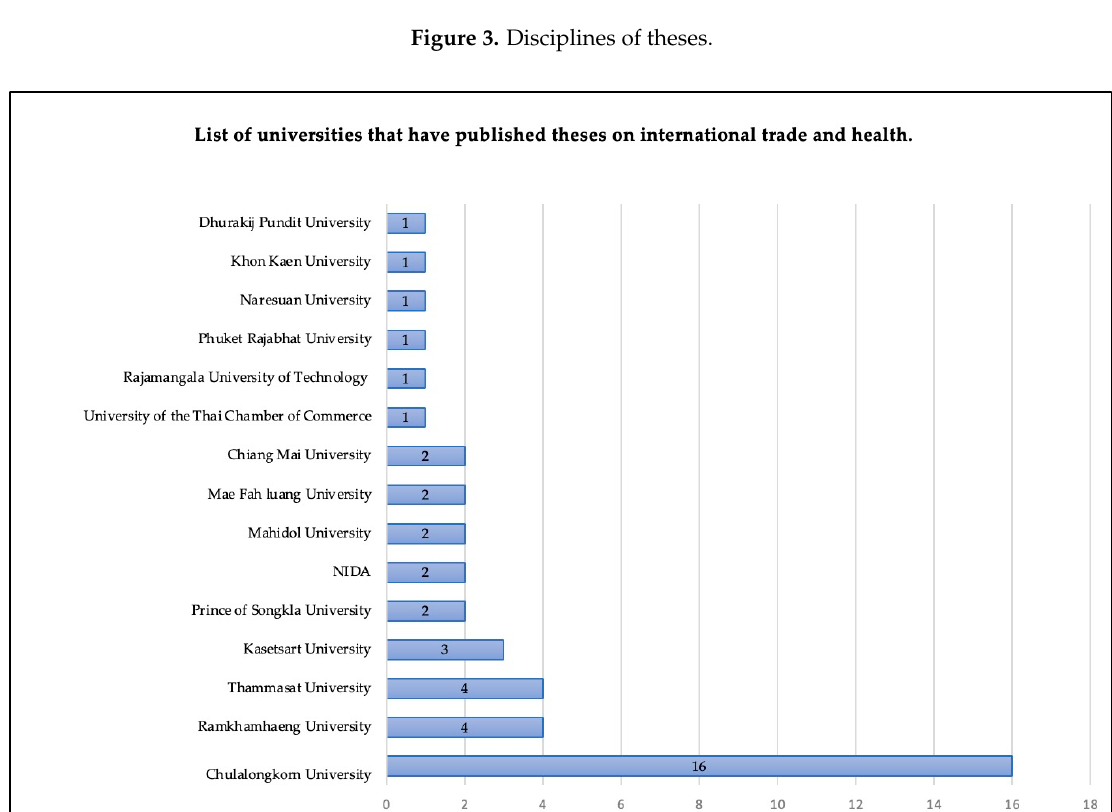
Figure 3. Disciplines of theses.